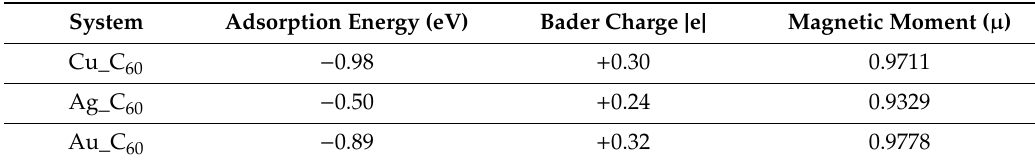
Table 4. Adsorption energies of atoms interacting with the surface of C 60 , Bader charge on the metal atoms and magnetic moments of the composites.